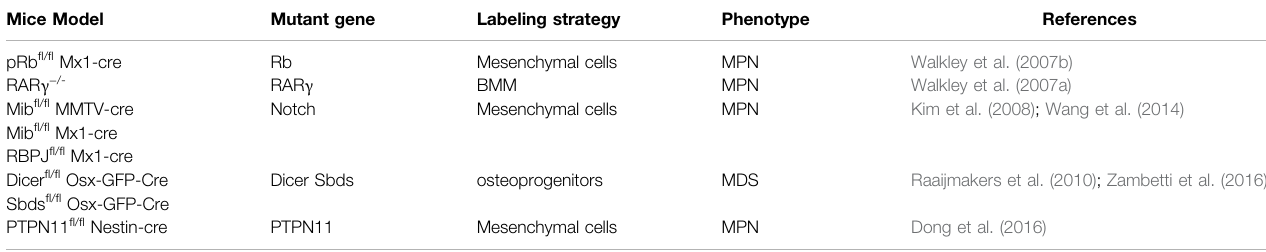
TABLE 1 | Multiple mutations in MSCs induce leukemogenesis.